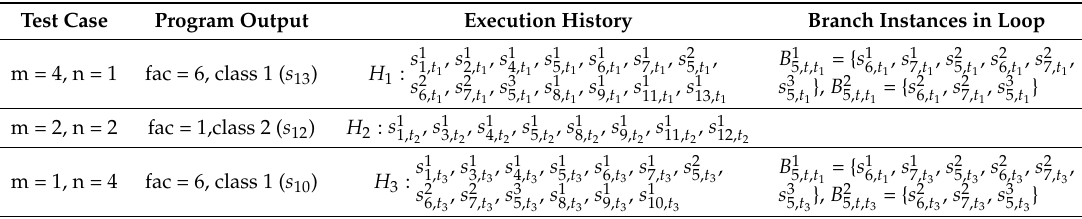
Table 2. The execution history of the test cases.